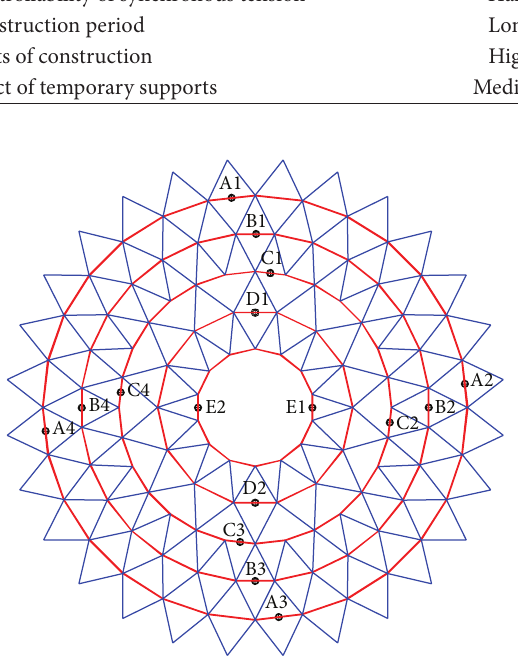
Figure 1: Sketch of tensioning points on hoop